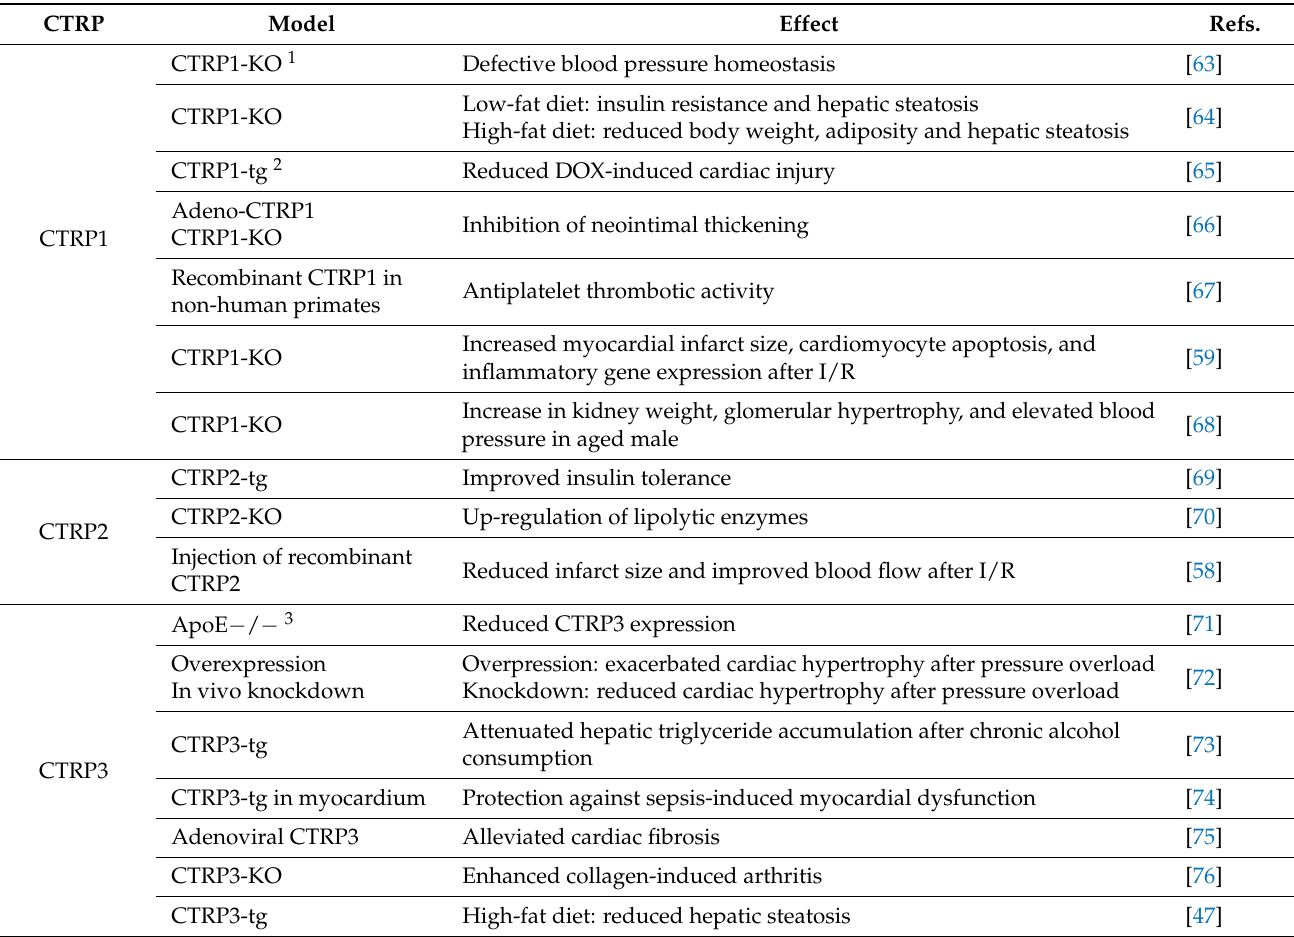
Table 2. CTRPs: lessons from animal